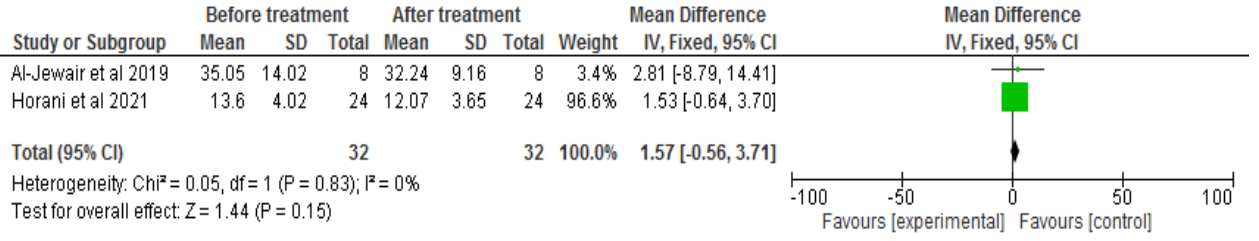
Figure 5. Funnel plot for clear aligner between before and after treatment. 3.4.3. Extraction and Non-Extraction Five studies report the Meta analysis between extraction and non-extraction. The pooled analysis showed no effect on extraction and non-extraction (MD = 0.37, CI - 1.11,1.85; Chi 2 = 62.54; I 2 = 94%, p = 0.62 > 0.05). Heterogeneity between the five studies is high (I 2 = 94%). Test for overall effect: Z = 0.49 ( p = 0.62) (Figures 6 and 7). Figure 6. Forest plot for extraction and non-extraction.